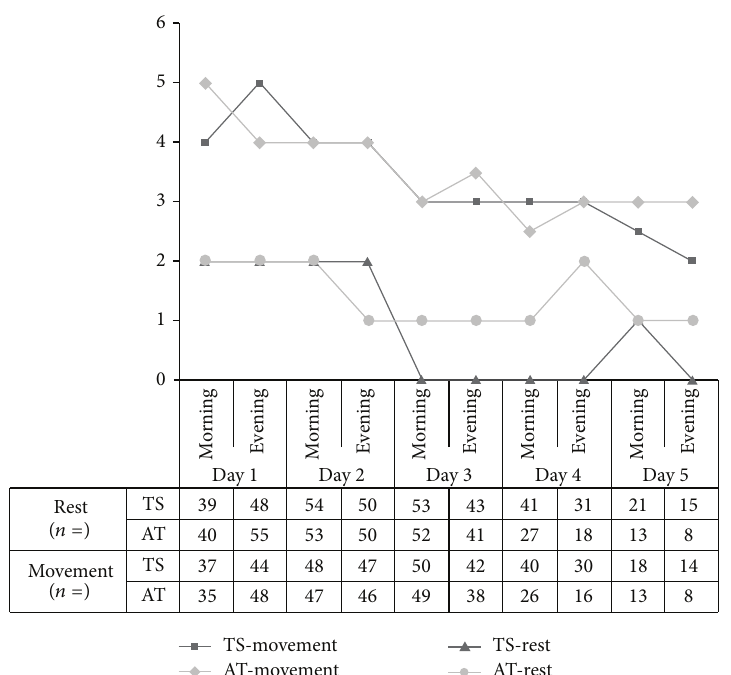
Figure 4: Comparison of analgesic quality by means of NRS (numeric rating scale). TS tunneled and sutured (“tunneled”); AT adhesive tape (“taped”). All data are presented as median. The total number of interviewed patients at different times is presented at the bottom of the graph. Not all patients were present at the time of the ward round.